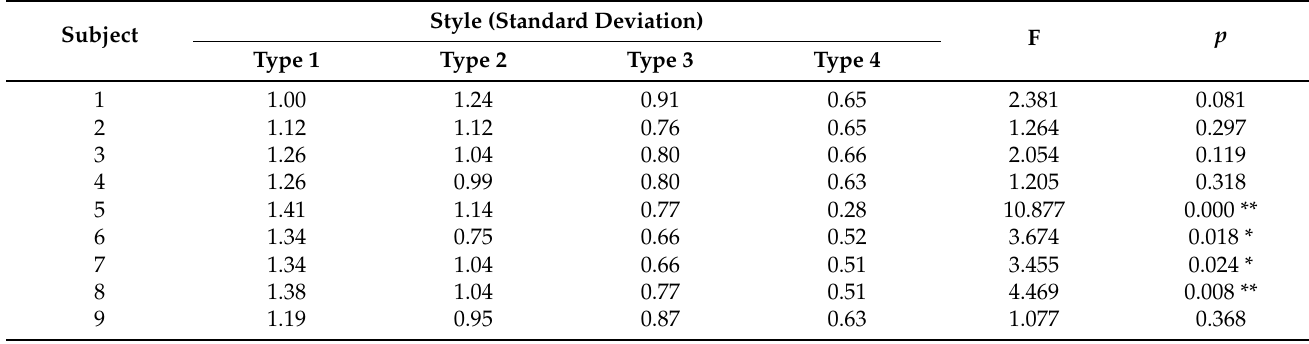
Table 17. Homogeneity test of user’s subjective preferences data for different styles of